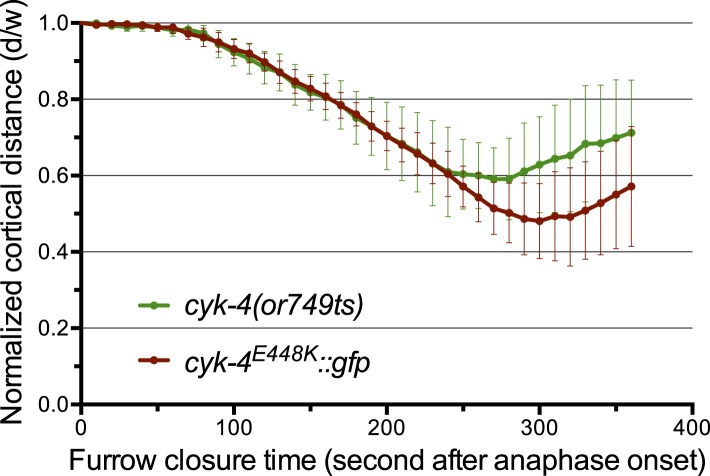
The CYK-4E448K::GFP transgene combined with cyk-4(RNAi) closely phenocopies cyk-4(or749ts).Quantification of furrow ingression rates in embryos of the indicated genotypes. Results are quantified as described in Figure 1G.